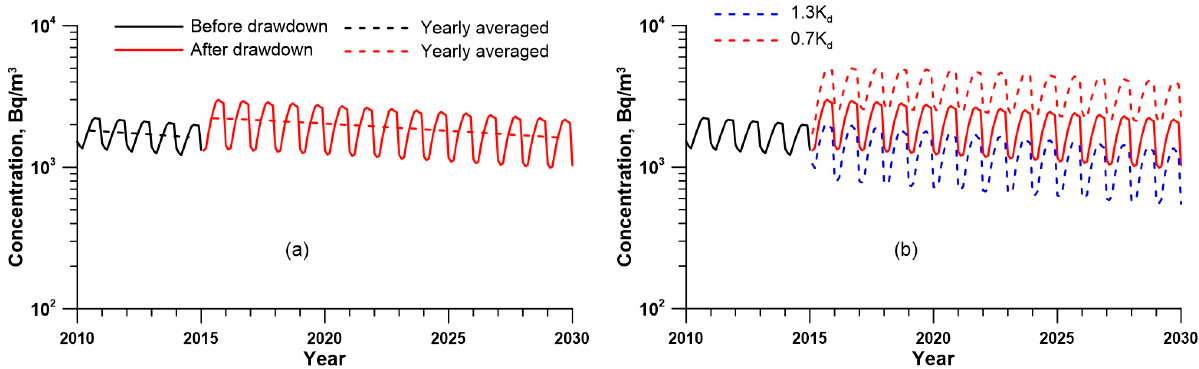
Figure 9. Changes in 137 Cs concentration in the water of Sector 1 as the result of water level draw- down: ( a ) when K d has not changed and ( b ) when K d has changed by 30% in both directions.